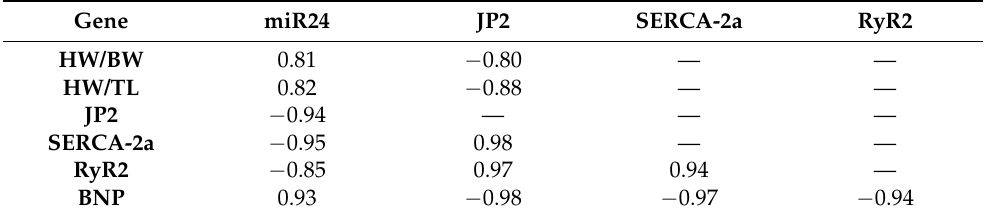
Table -1. Correlation between studied parameters in HF rats treated with LN, PA and their combi- nation.